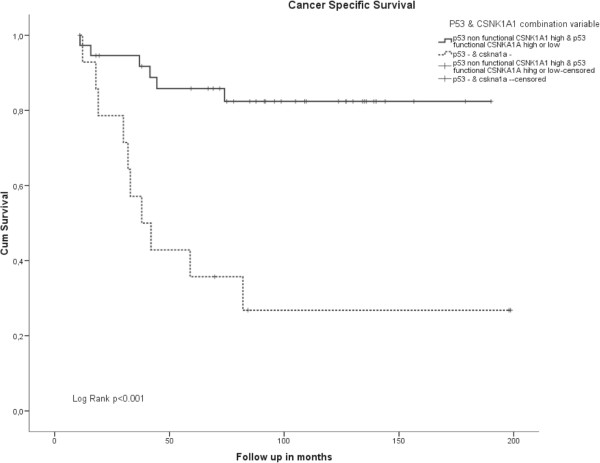
Kaplan Meier for CSS according to p53 and CSNK1A1 combination variable.